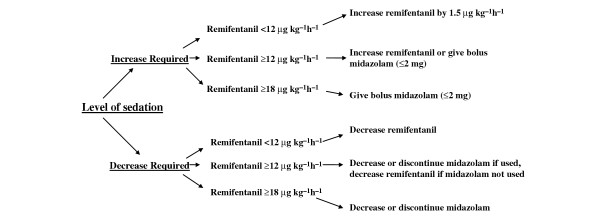
The dosing algorithm.